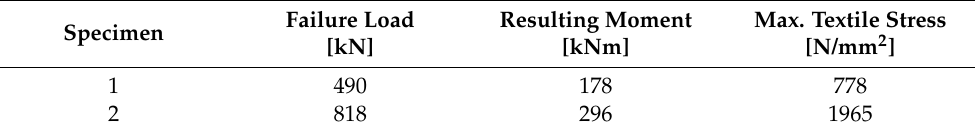
Figure 20. Moment-deflection-curves of the two bending tests. Table 6. Results of the bending tests.